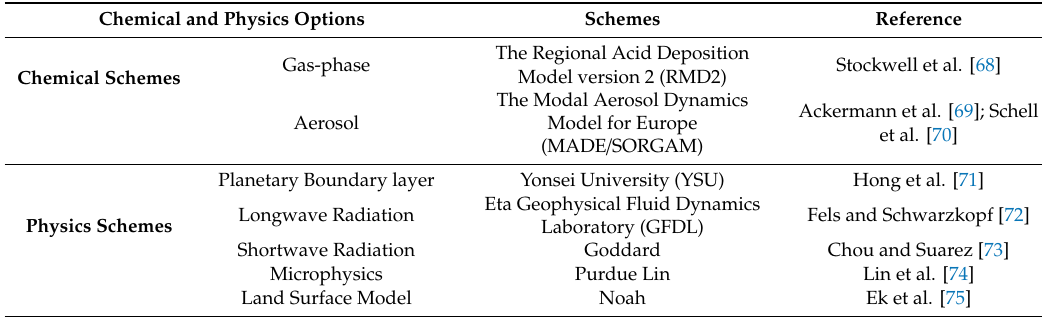
Table 2. WRF / Chem configurations for physical and chemical